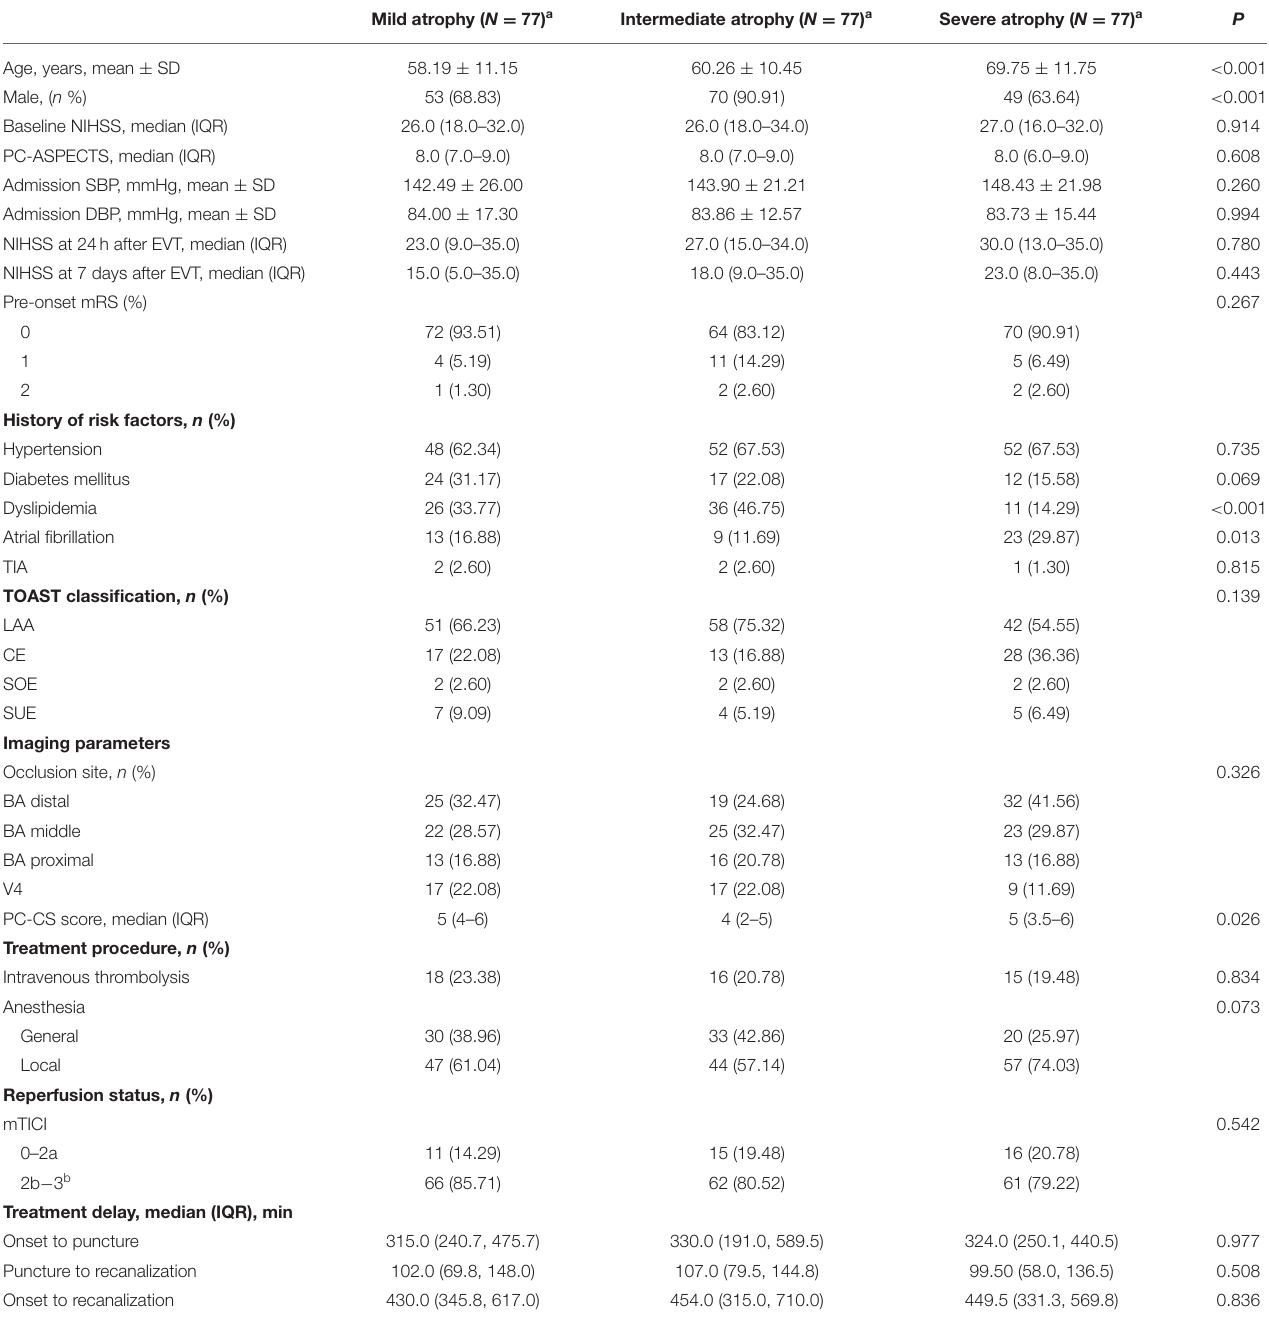
TABLE 2 | Baseline clinical characteristics according to brain atrophy levels. Mild atrophy ( N = 77)